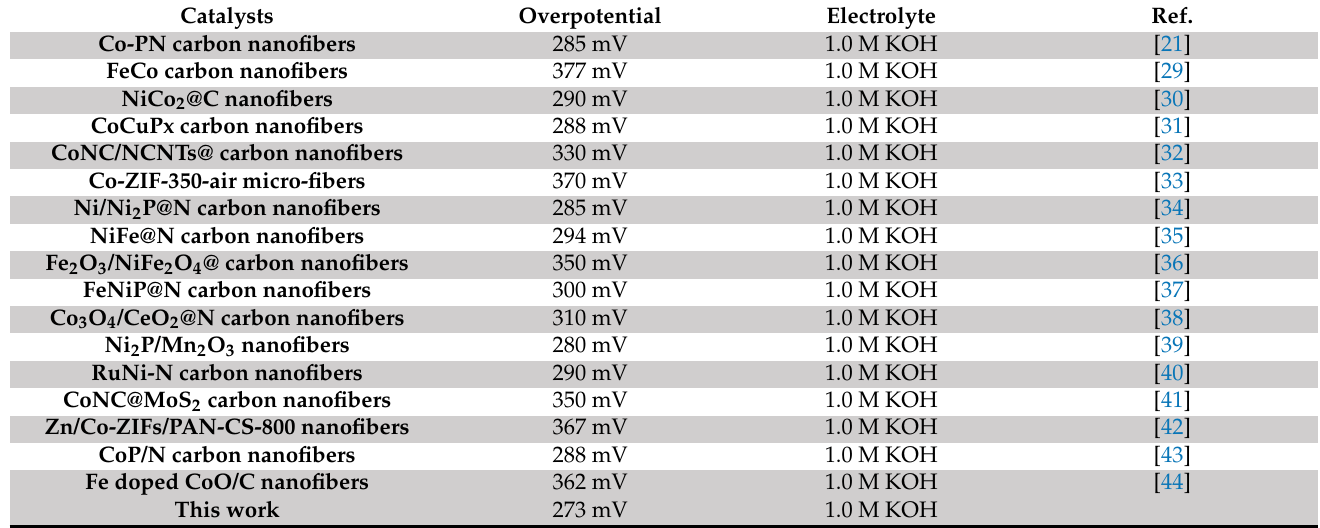
Table 1. Overpotential of the hollow CuCo 2 O 4 nanofibers electrode material for comparison with as-reported related electrodes at 10 mA cm − 2 . Catalysts Overpotential Electrolyte Ref. 285